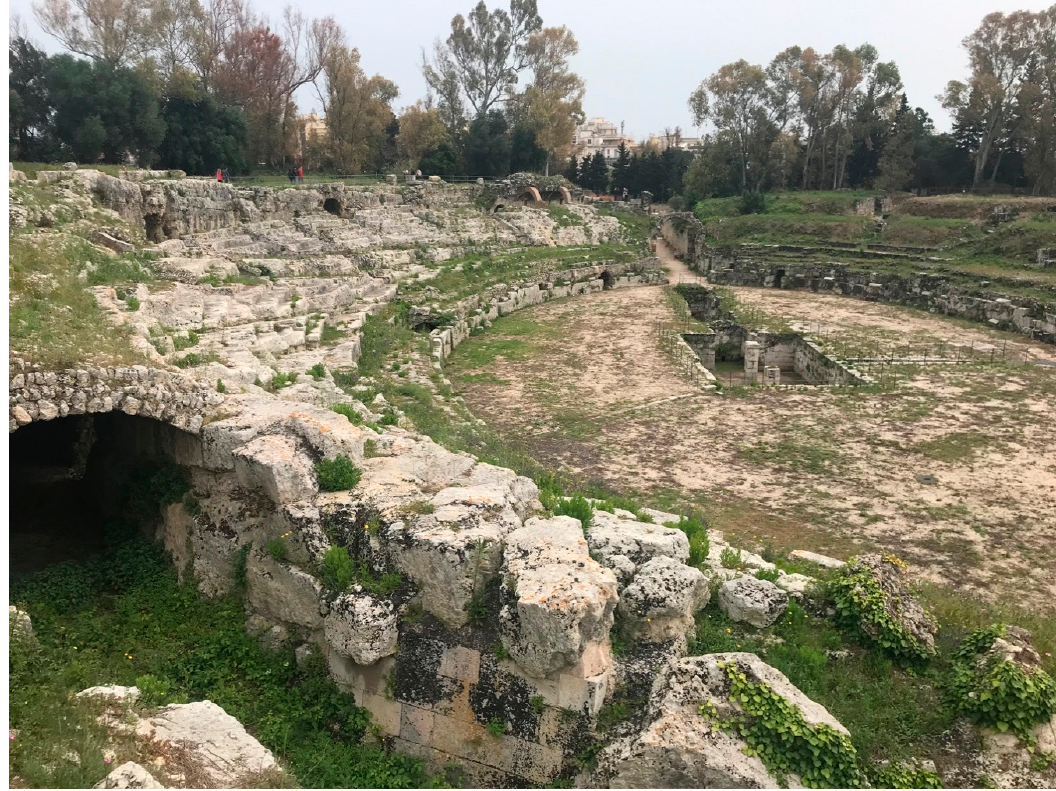
Figure 2. Vegetation growth. The Greek Theatre of Syracuse (UNESCO World Heritage Site), Sicily, Italy, April